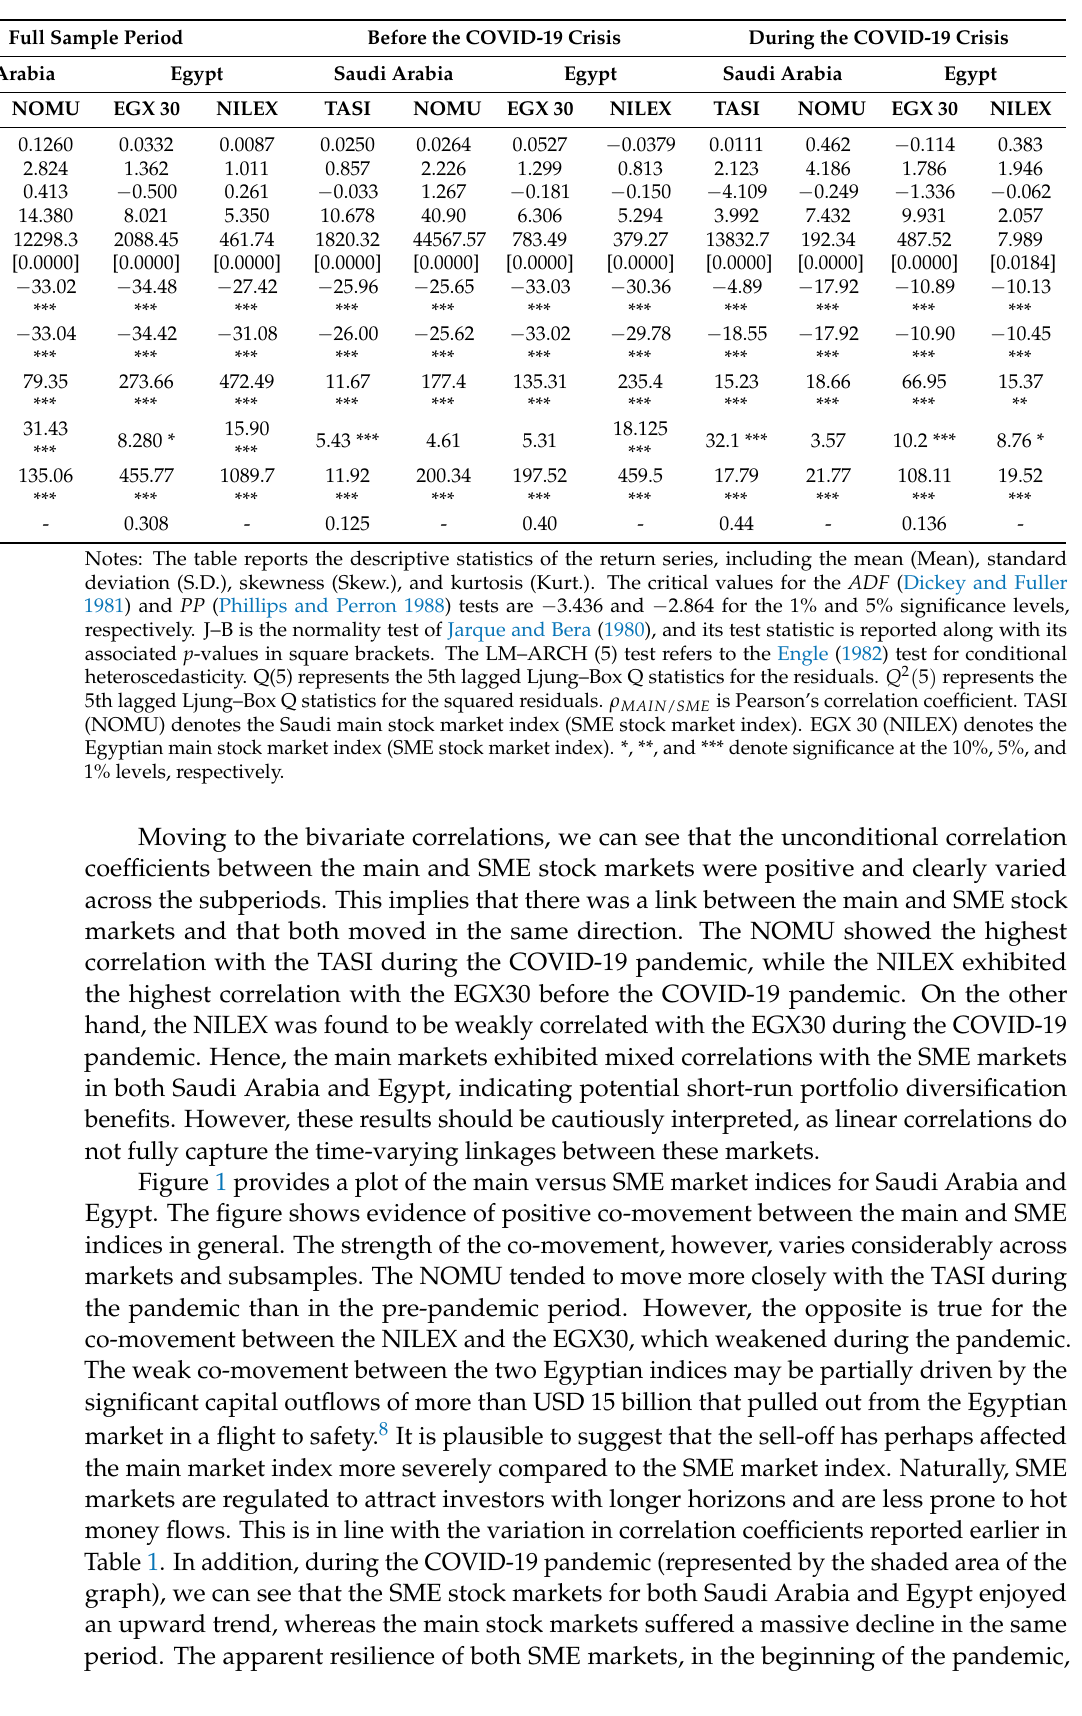
Table 1. Descriptive statistics of daily stock market